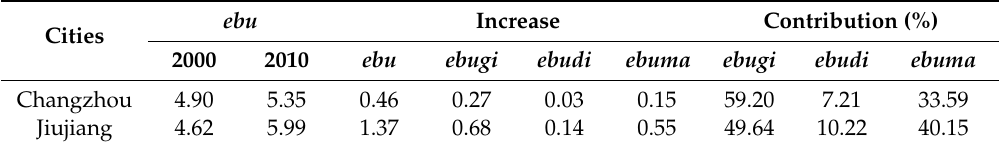
Table 4. Change in environmental benefits of urban land use in Changzhou and Jiujiang, 2000–2010. ebu Cities